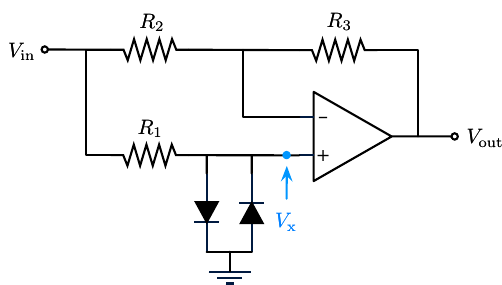
Figure 5. Schematic of a single folding cell in the middle section of the Serge Wave Multipliers (VCM). Figure adapted from [63]. Table 3. Component information for the Serge wavefolder circuit shown in Figure 5.